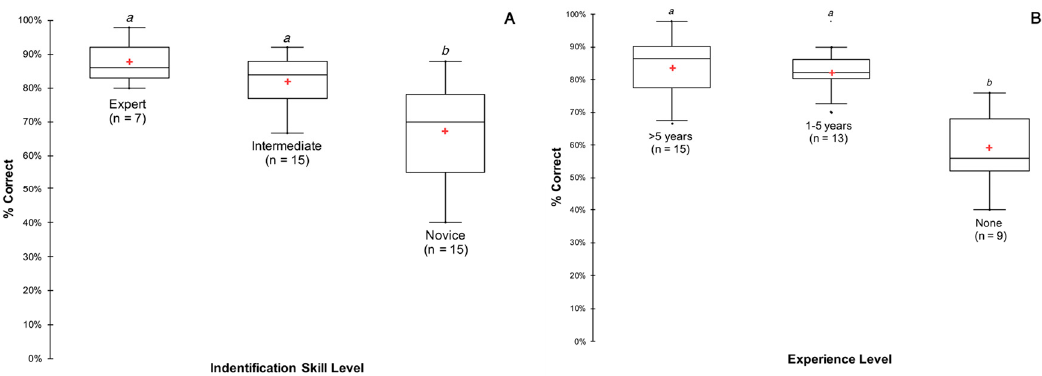
Figure 5. Box plots of scores showing mean, median, quartiles, and outliers, based on identification skill levels ( A ) and years of experience ( B ) in correctly identifying pigtoe mussels. Significant groupings from a Kruskal–Wallis and Dunn post-hoc test ( p < 0.05) are shown as a and b.